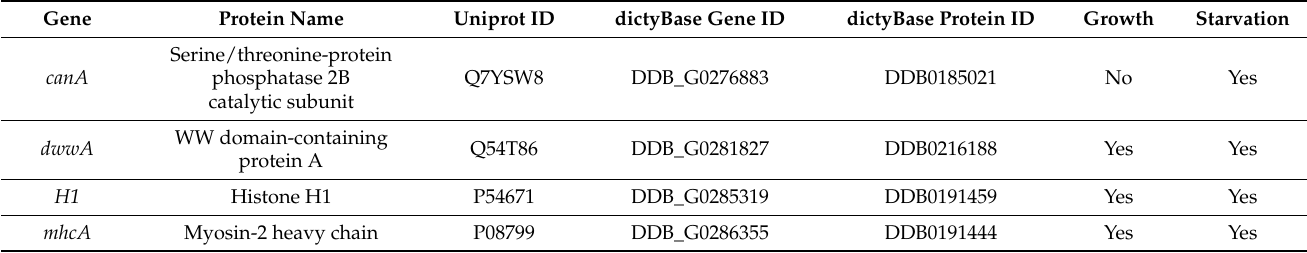
Figure 2. Validation of mass spectrometry results by western blotting. Calmodulin (CaM) immunoprecipitation (IP) fractions from growth-phase and starved cells were separated by SDS-PAGE and analyzed by western blotting. ( A ) Western blots probed with anti-CaM. ( B ) Western blots probed with anti-MhcA (myosin II heavy chain, positive control), anti-Snf12 (SWI/SNF protein 12, positive control), anti-VatC (catalytic subunit of V-ATPase, negative control), and anti-CtnA (countin, negative control). Molecular weight markers (in kDa) are shown to the left of each blot. WC, whole cell lysate (7 µ g total protein). IP, CaM IP fraction (11 µ L). PD, protein-depleted fraction (7 µ g total protein). Table 1. List of proteins revealed in calmodulin (CaM) immunoprecipitation (IP) fractions with the gene ontology (GO) term identifier